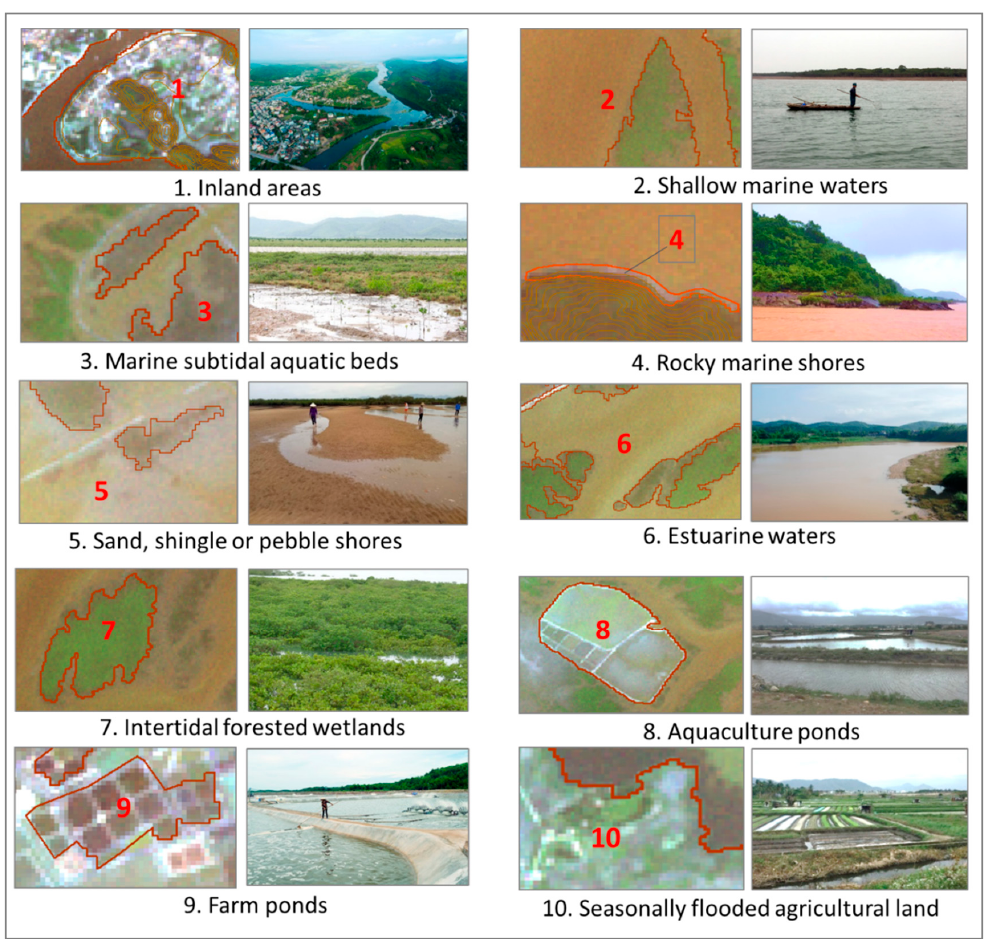
Figure 3. Samples in the fields taken in 3 / 2020 and on the Sentinel-2 image obtained on 22 / 11 / 2019 in Tien Yen estuary, Quang Ninh province. The photos were taken by Dang Kinh Bac.